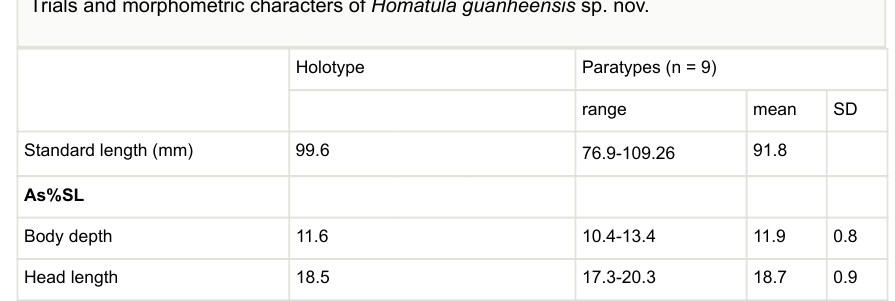
rays; origin of anal fin closer to pelvic fin origin than to caudal fin base, its tip not reaching half distance from anal-fin origin to caudal-fin base. Posterior margin of caudal fin micro-rounded; adipose crests along its dorsal and ventral mid-lines without extending through the origin of anal fin. Intestine formed as a bend, not reaching posterior surface of the U-shaped stomach. Gas bladder osseous, anterior chamber invisible, fully enclosed in a capsule; posterior chamber degenerated.